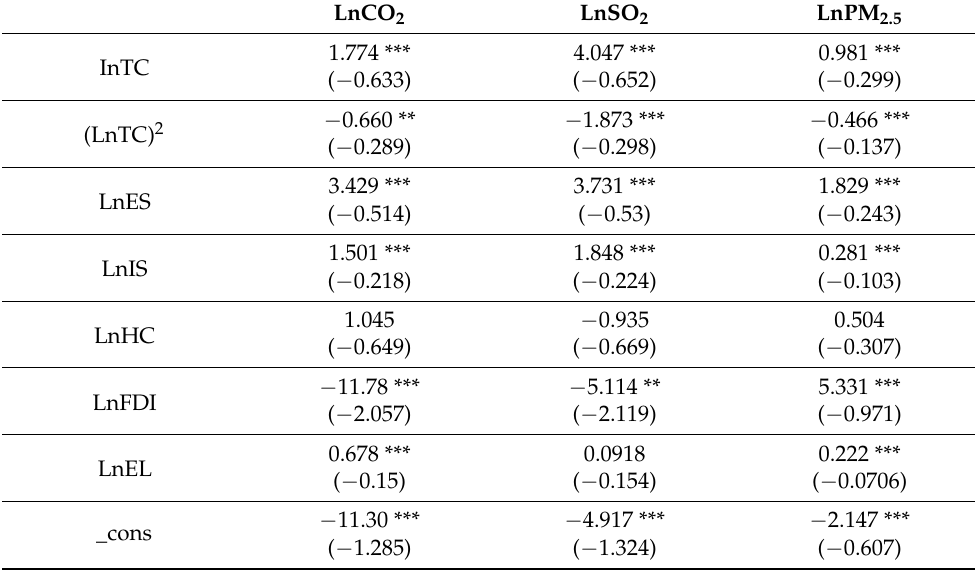
Table 6. Regression results of influencing